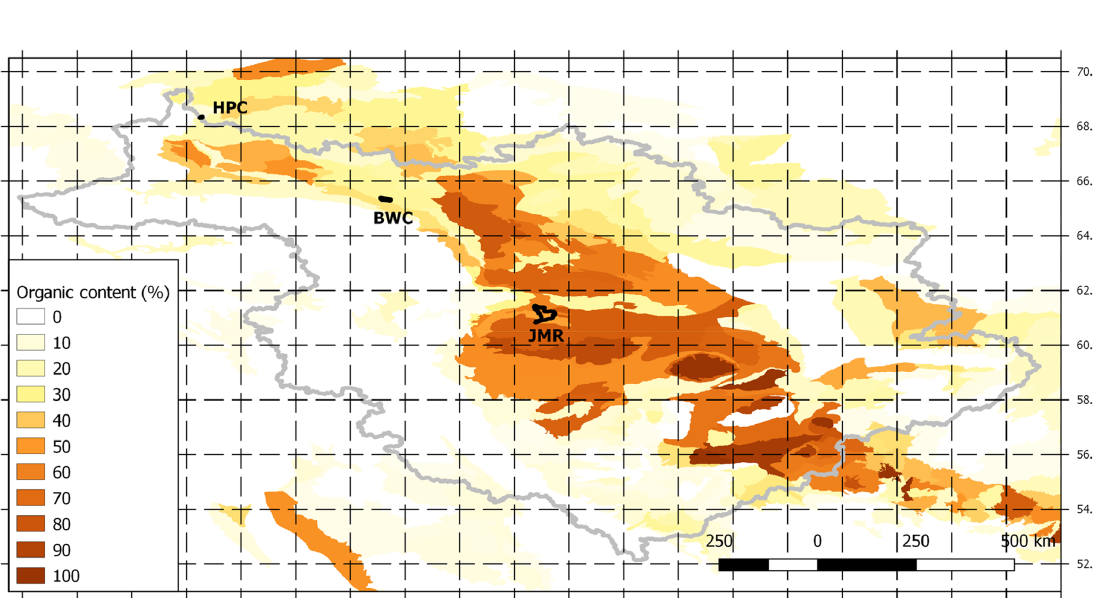
Figure 4. Gridded organic matter in soil at 0.125 ◦ resolution for the MRB, processed from the Soil Landscapes of Canada (SLC) v2.2 dataset (Centre for Land and Biological Resources Research,